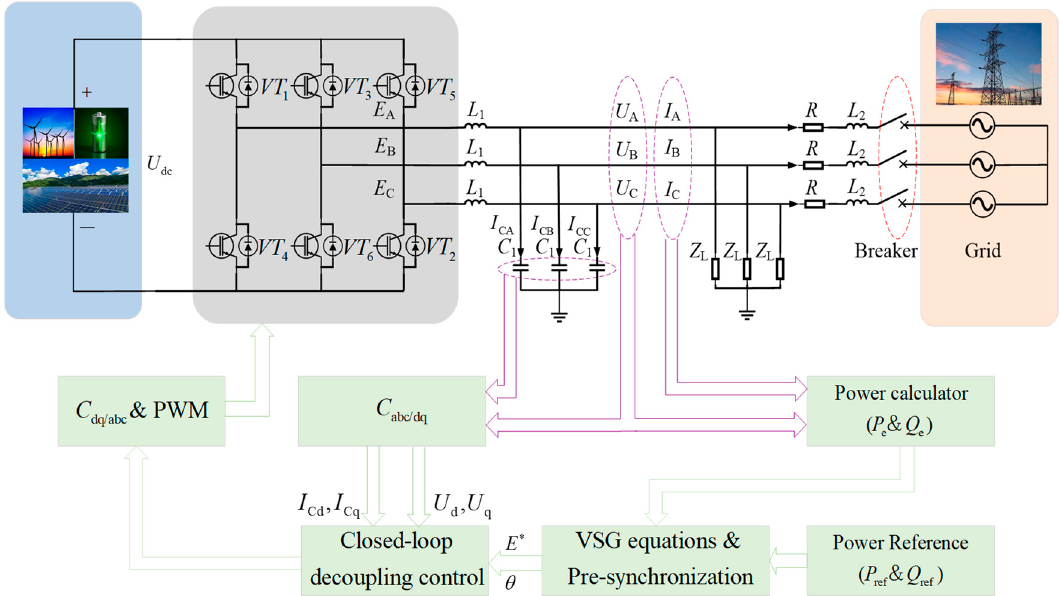
Figure 1. Topology and general control structure of grid-connected inverter.